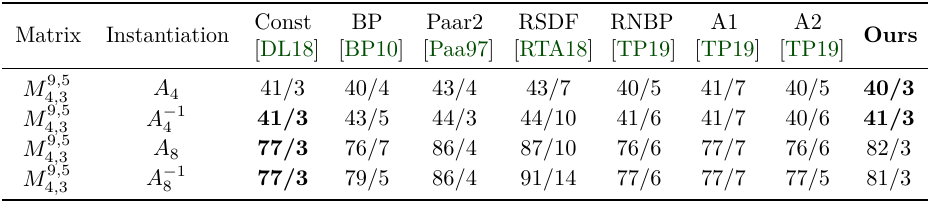
Table 3: The XOR number/depth of implementation cost of matrices with depth 3 in